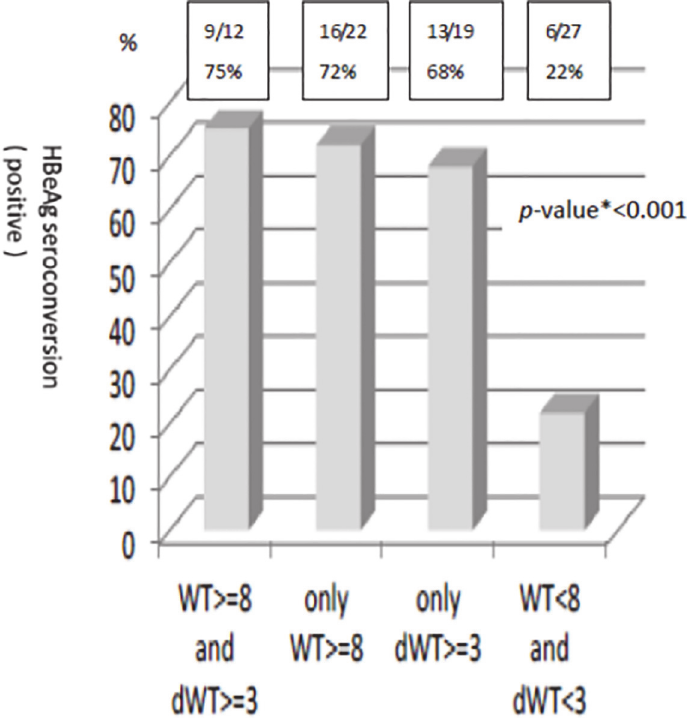
Fig 2. The power of combining nodal width (WT) at acute flare stage and nodal change (dWT) between acute flare and recovery stage to predict HBeAg seroconversion. * p -value is from Pearson ’ s chi- square test.